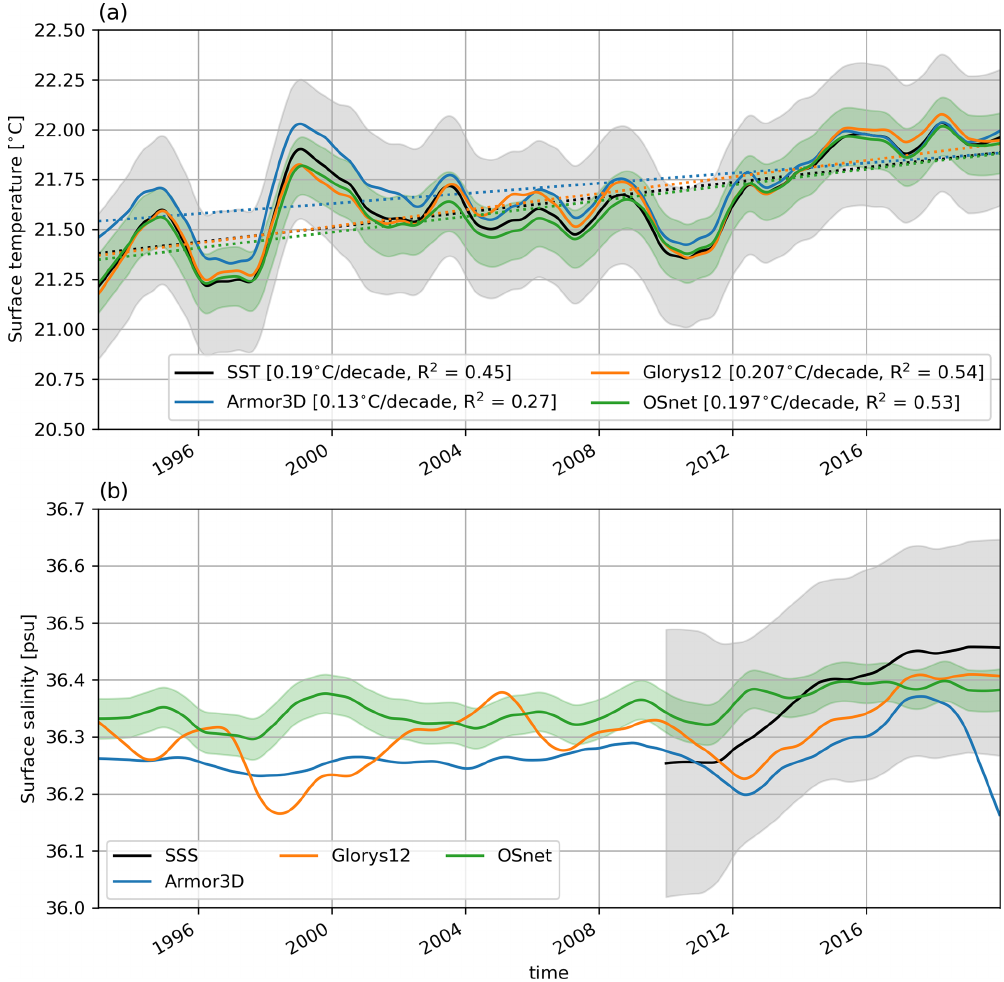
Figure 12. Nonseasonal low-frequency time series of surface temperature (a) and salinity (b) averaged over the region excluding the shelf shallower than 1000m. It is extracted with a seasonal-trend decomposition. The linear trends of temperature are displayed with dashed lines, and their slope and R 2 are in the legend of panel (a) . The grey shaded areas are the SST mapping error in (a) and the SSS random error (b) . The green shaded areas are the OSnet confidence intervals, i.e., the standard deviation of the 15 bootstrapped